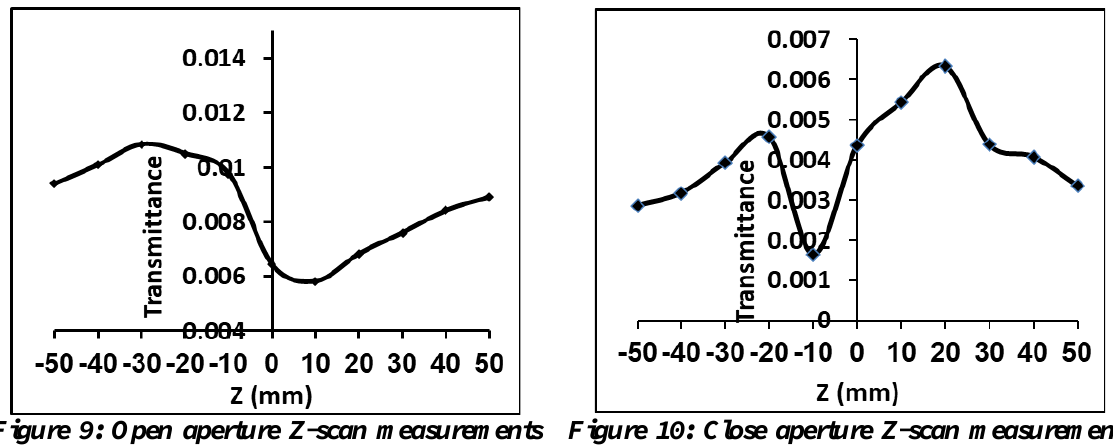
Figure 9: Open aperture Z-scan measurements of Vitamin D -5000IU soft gel. 3 Table 4: Nonlinear properties of Vitamin D